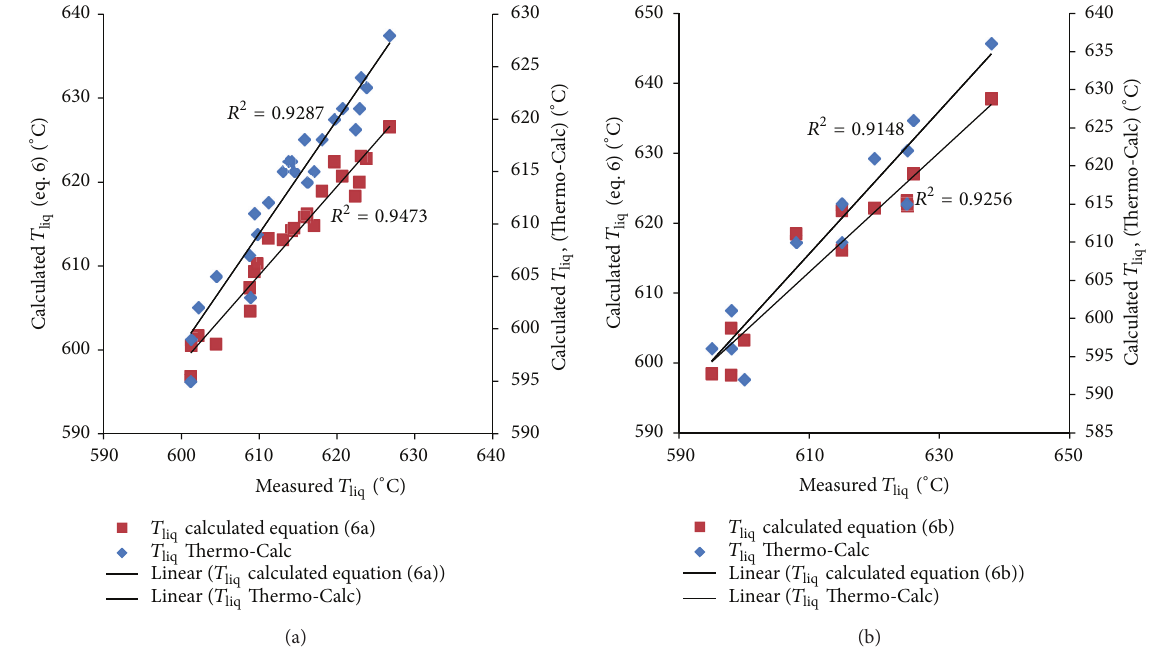
Figure 6: Predicted versus measured liquidus temperatures calculated applying the method of equivalency, (a) aluminum alloys (6a) and (b) magnesium alloys (6b).